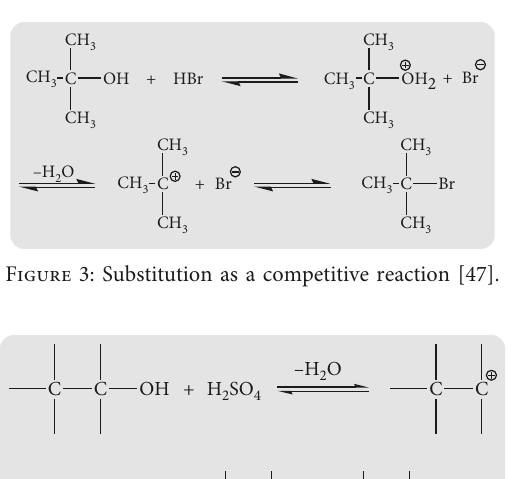
Figure 5: Reaction of HG dehydration under catalytic influence [52].